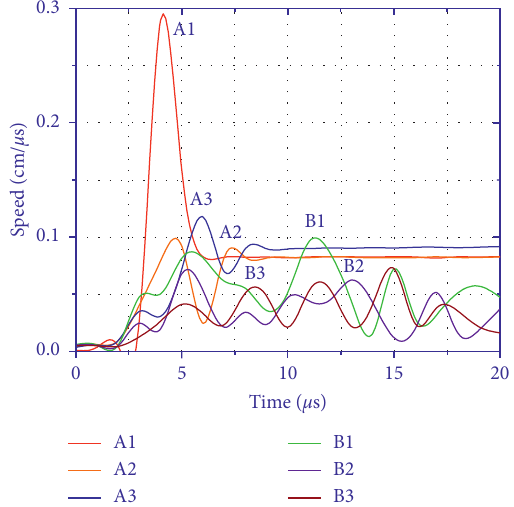
Figure 20: Joint velocity curve of no-shot mud-charge